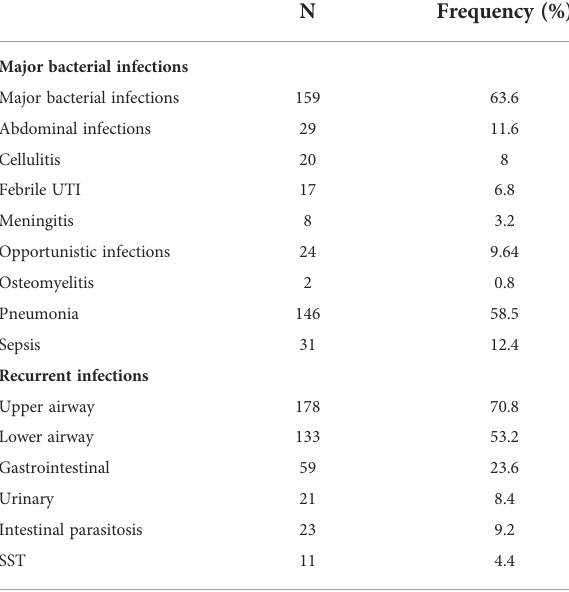
TABLE 2 Descriptive statistics of the major bacterial and the recurrent infections in the GTEM-SEMI-CVID Registry.